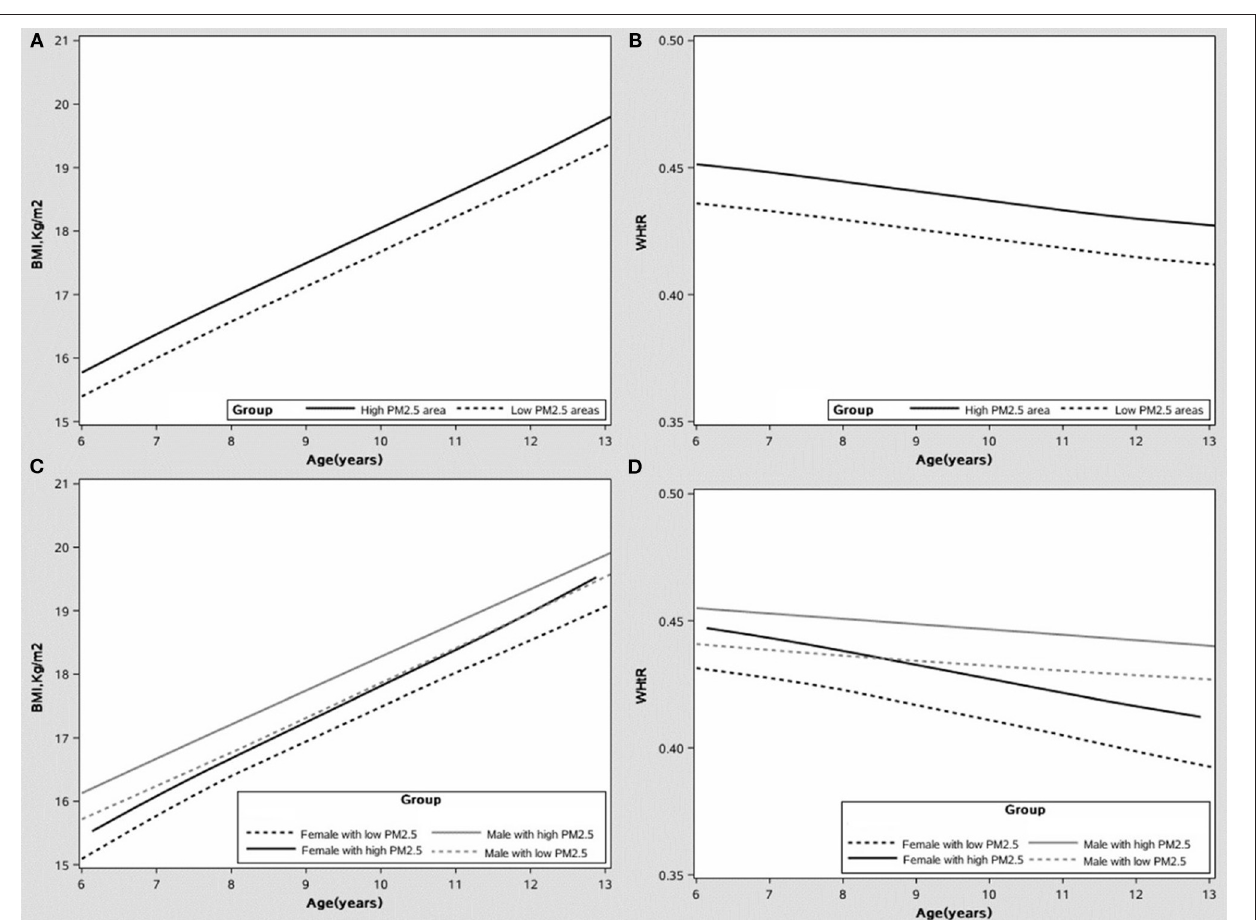
FIGURE 1 | The growth curve of the body mass index (BMI) and waist-to-height ratio (WHtR) under different PM2.5 exposure levels, after adjusting covariates. (A) The growth curve of BMI. (B) The growth curve of WHtR. (C) The growth curve of BMI by sex. (D) The growth curve of WHtR by